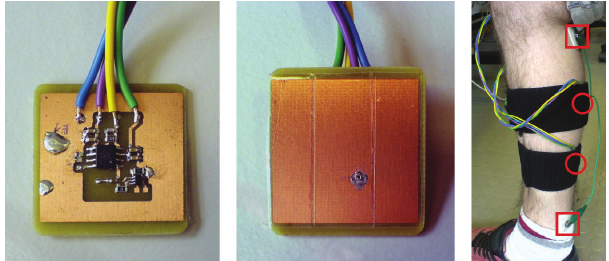
Fig.4: Upper and lower sides of the active electrode and the measuring arrangement. In the right picture the blue circles mark the positions of the outer current electrodes and the red circles mark the position of the measuring